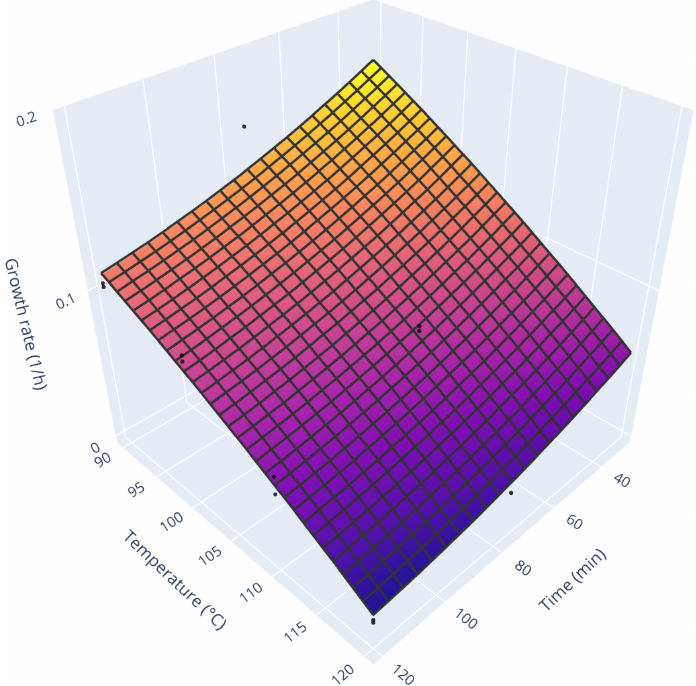
Figure 5. Response surface of the yeast growth rate in